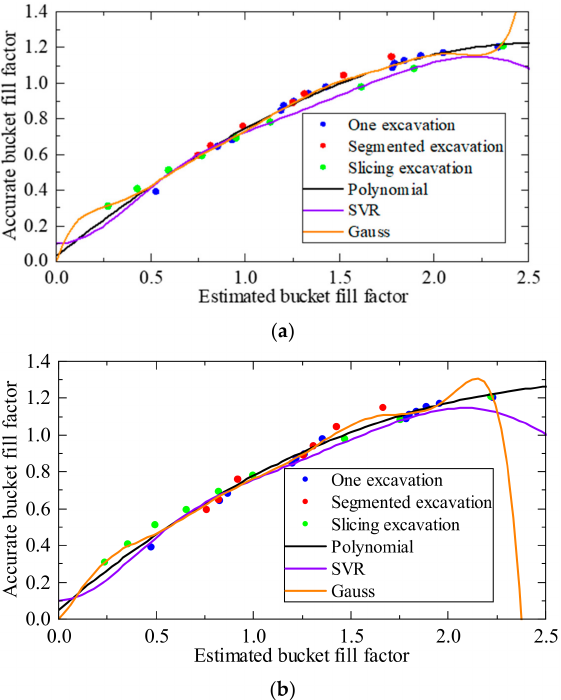
Figure 12. Prediction regression curve of shovel full rate under different fitting surface methods. ( a ) Polynomial Surface Fitting; ( b ) Neural Network Surface